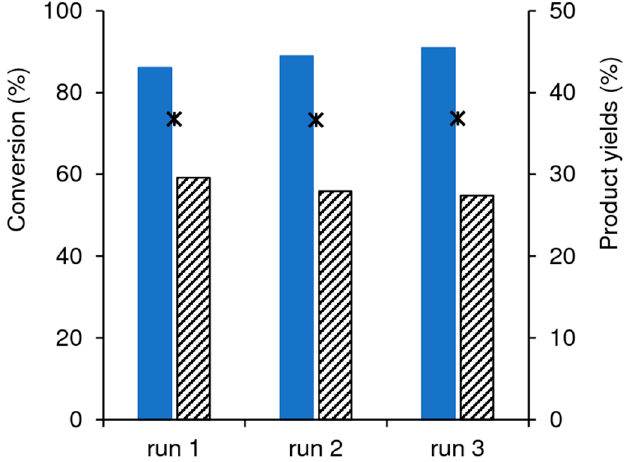
Figure 7. Catalytic performance of 1 in consecutive runs of the Fur/Gly reaction at 50 °C/4 h (38 g cat L − 1 ), after simple washing/drying: conversion (*) and dioxolane (blue bars) and dioxane (striped bars) yields.